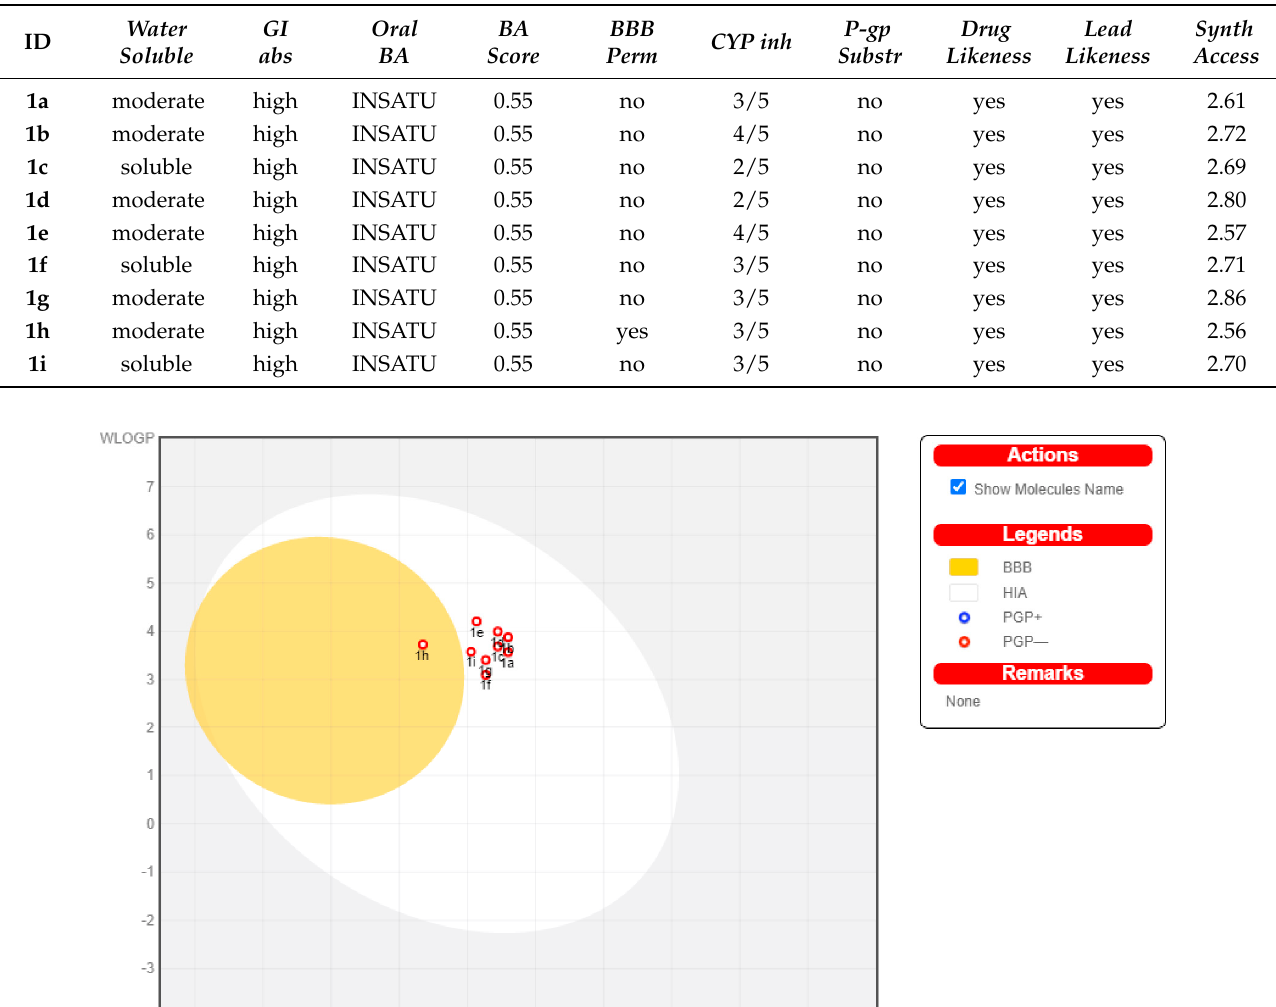
Table 4. ADME properties of the designed arylsulfonyl hydrazones: water solubility ; GI abs —